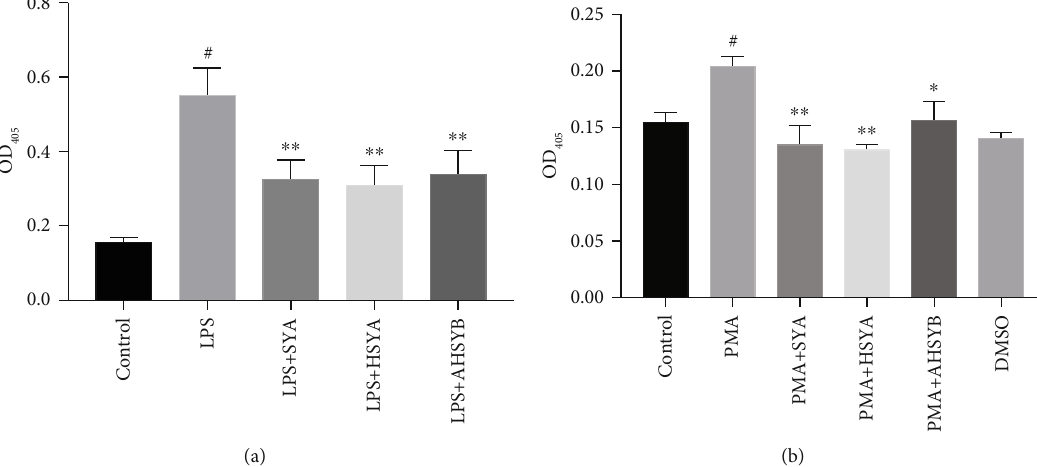
Figure 6: E ff ects of SYA, HSYA, and AHSYB on NETs. (a) E ff ects of SYA, HSYA, and AHSYB on plasma MPO-DNA complex in LPS-induced ALI mice. The values presented are mean ± SEM , # P < 0 : 05 vs the control group; ∗∗ P < 0 : 01 vs the LPS group. (b) E ff ects of SYA, HSYA, and AHSYB on MPO-DNA complex in PMA-induced HL-60 cells. # P < 0 : 05 vs the control group; ∗ P < 0 : 05 vs the PMA group; ∗∗ P < 0 : 01 vs the PMA